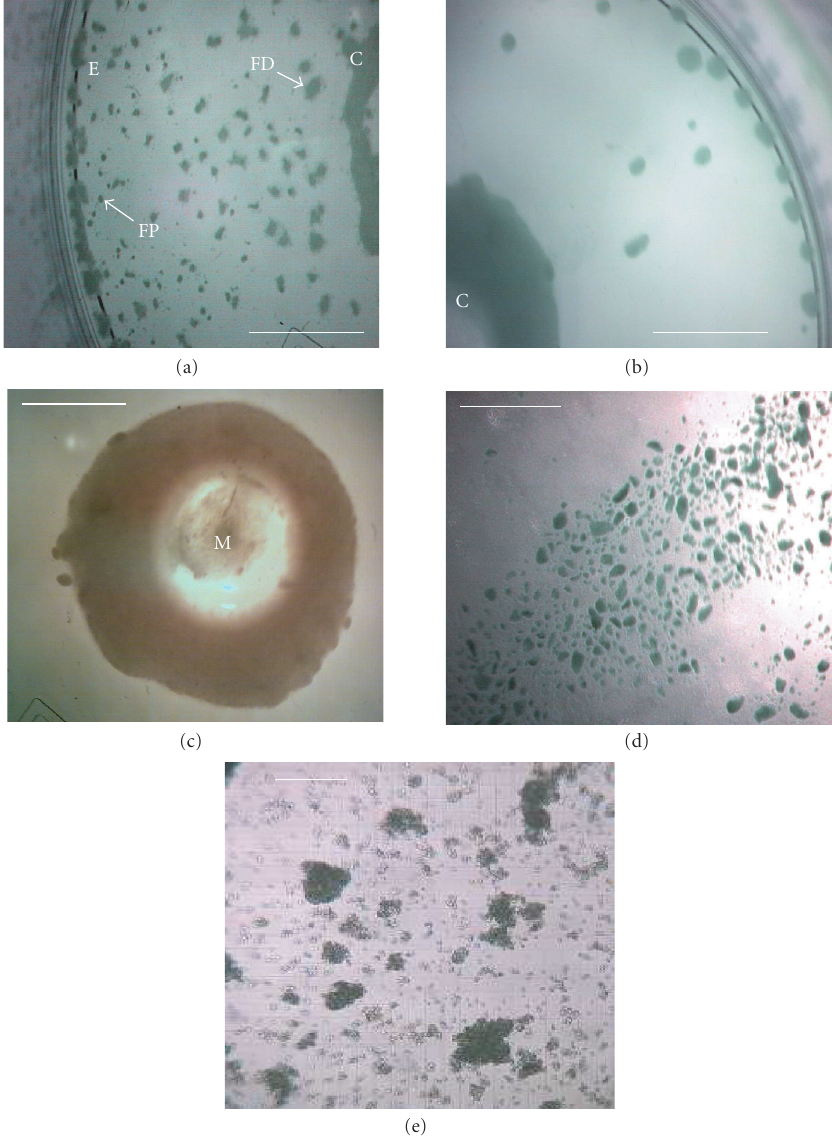
Figure 5: Micrographs of bioreactor cultures. (a) Base of a sector of an RDB bioreactor vessel following culture of EL-4 cells (without impeller agitation). EL-4 cells are dispersed across the surface as irregularly shaped plaques, with plaques merging into more confluent, continuous layers centrally (C) and along the circumferential edge (E), near the vessel side-wall. Intervening plaques located closer to the sidewall appear more focal punctate (FP) compared to more centrally located flattened discoid plaques (FD). (b) Base of a bioreactor vessel following culture of EL-4 cells with impeller agitation. Adherent plaques are larger discoid plaques, predominantly located centrally (C) and circumferentially (E), with a larger confluent tumor-like plaque with similarly smooth and flattened discoid appearance. (c) Magnified image of the central aggregate or “tumor” appearing in (b) showing a discoid, opaque colony with smooth edges. The centre of the plaque appears transparent due to a central dimple (manufacturing artefact) located on the plastic surface, a manufacturing artefact of the vessel over which a type of attenuated monolayer is visible (M). (d) Image of EL-4 aggregates of variable size, as viewed within a static tissue culture flasks. (e) Magnified image of EL-4 spheroid aggregates and disaggregated single cells contained on a hemocytometer slide, showing that spheroids are comprised of a homogeneous colony of densely packed, adherent cells. Scale bar = 10mm (a)–(d) and 0.25 mm